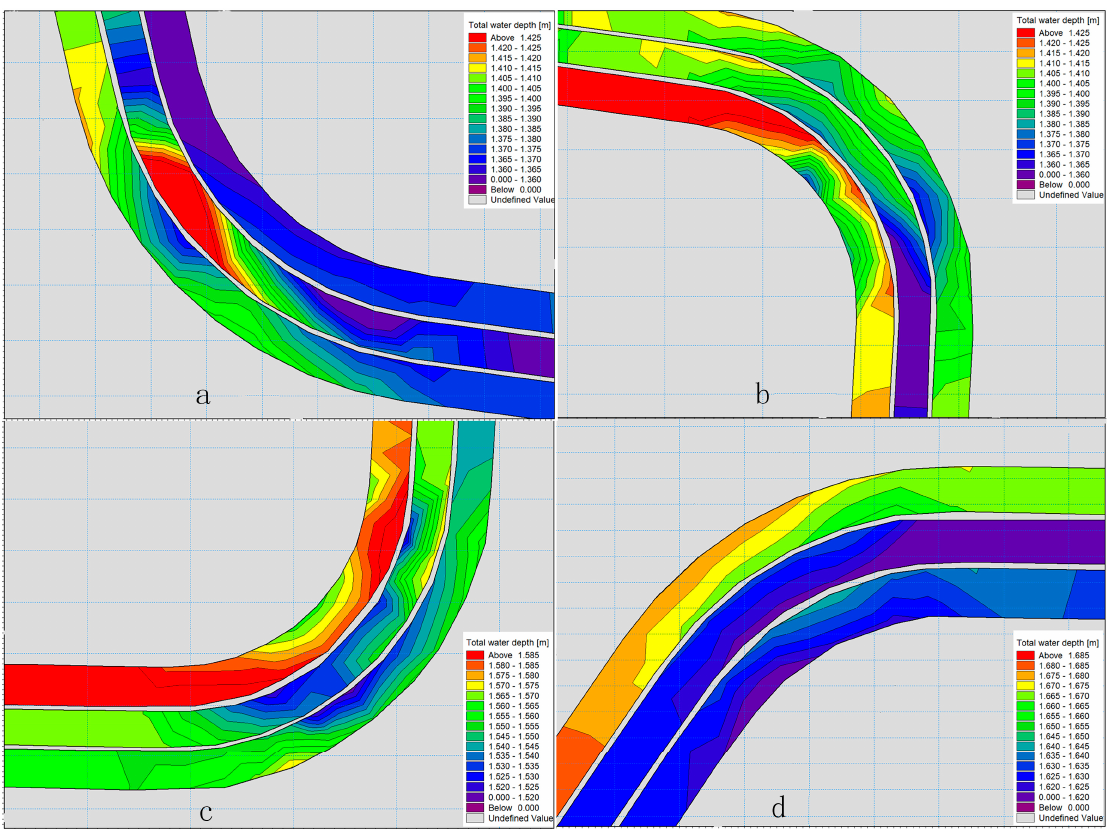
Figure 6. Enlarged water depth map of the four turns of 3-channel culverts (simulation scenario 1). ( a ) Enlarged water depth map of the locations marked with red circles 1 in Figure 5a; ( b ) Enlarged water depth map of the locations marked with red circles 2 in Figure 5a; ( c ) Enlarged water depth map of the locations marked with red circles 3 in Figure 5a; ( d ) Enlarged water depth map of the locations marked with red circles 4 in Figure 5a.